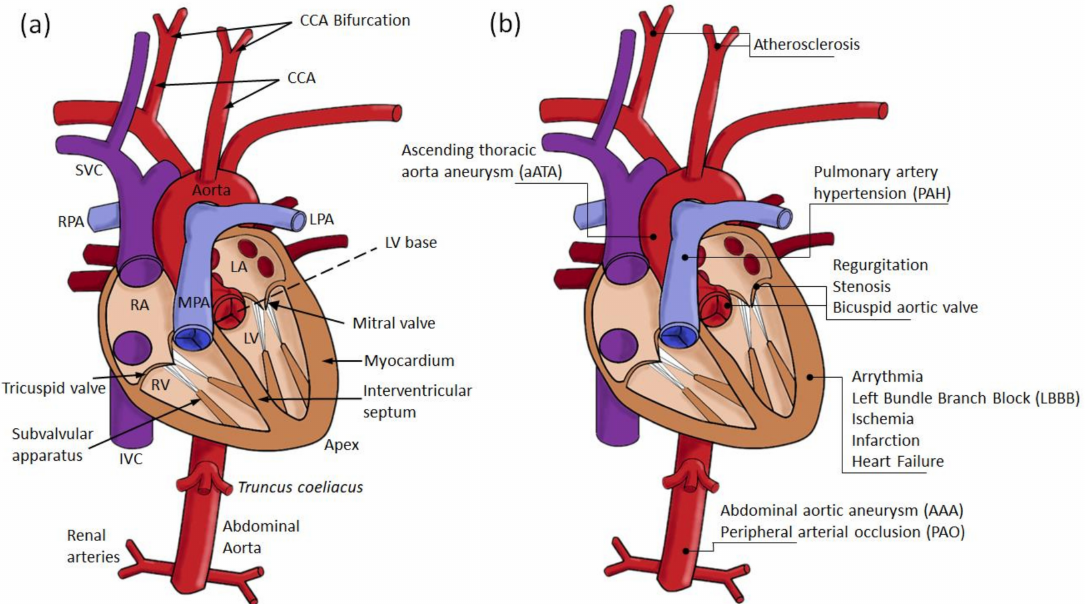
Figure 10. ( a ) Schematic representation of the human heart with anatomical references. ( b ) Location of human pathologies studied with inverse models. Acronyms: CCA, common carotid artery; IVC, inferior vena cava; LA, left atrium; LPA, left pulmonary artery; LV, left ventricle; MPA, main pulmonary artery; SVC, superior vena cava; RA, right atrium; RPA, right pulmonary artery; RV, right